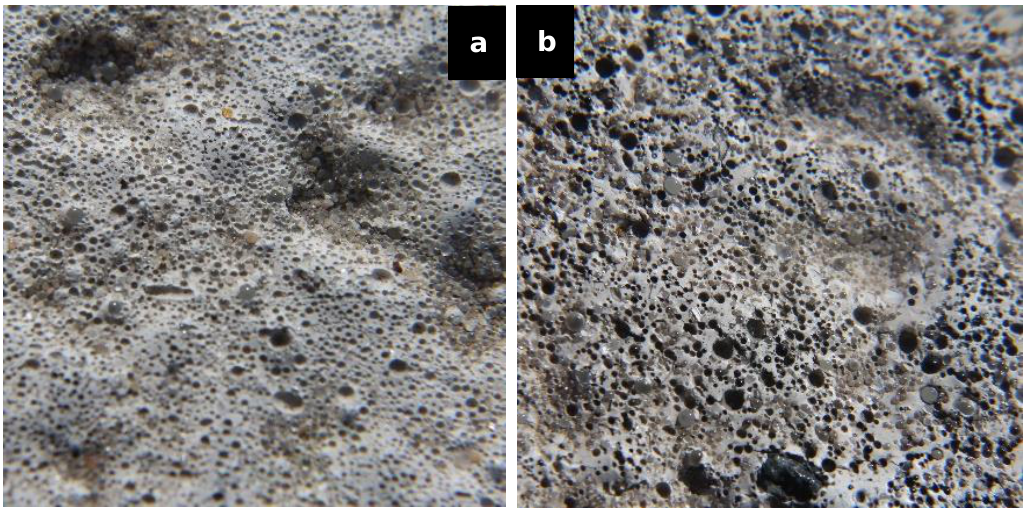
Figure 9. In situ surface detail after 12 months of service: ( a ) S8 sample; ( b ) S13 sample.